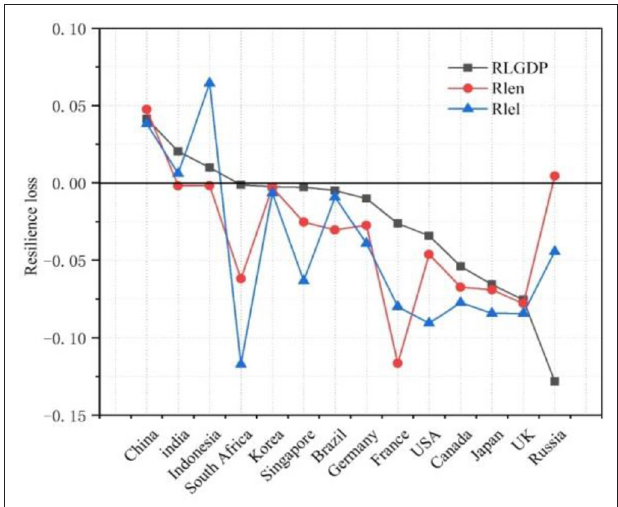
FIGURE 3 | Resilience loss for GDP, final energy consumption, and final electricity consumption.